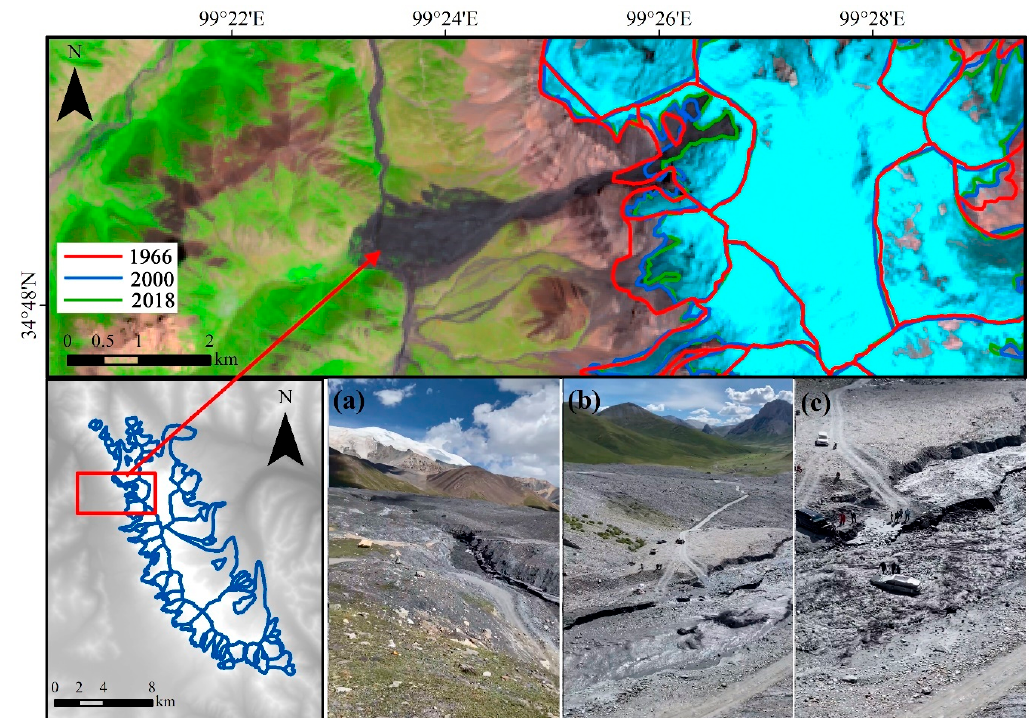
Figure 9. Ice avalanche in the Maqên Gangri Glacier (a, b, and c show the debris flow in the Maqên Gangri Mountain on August 8, 2022; The satellite image is Landsat 8, acquired in